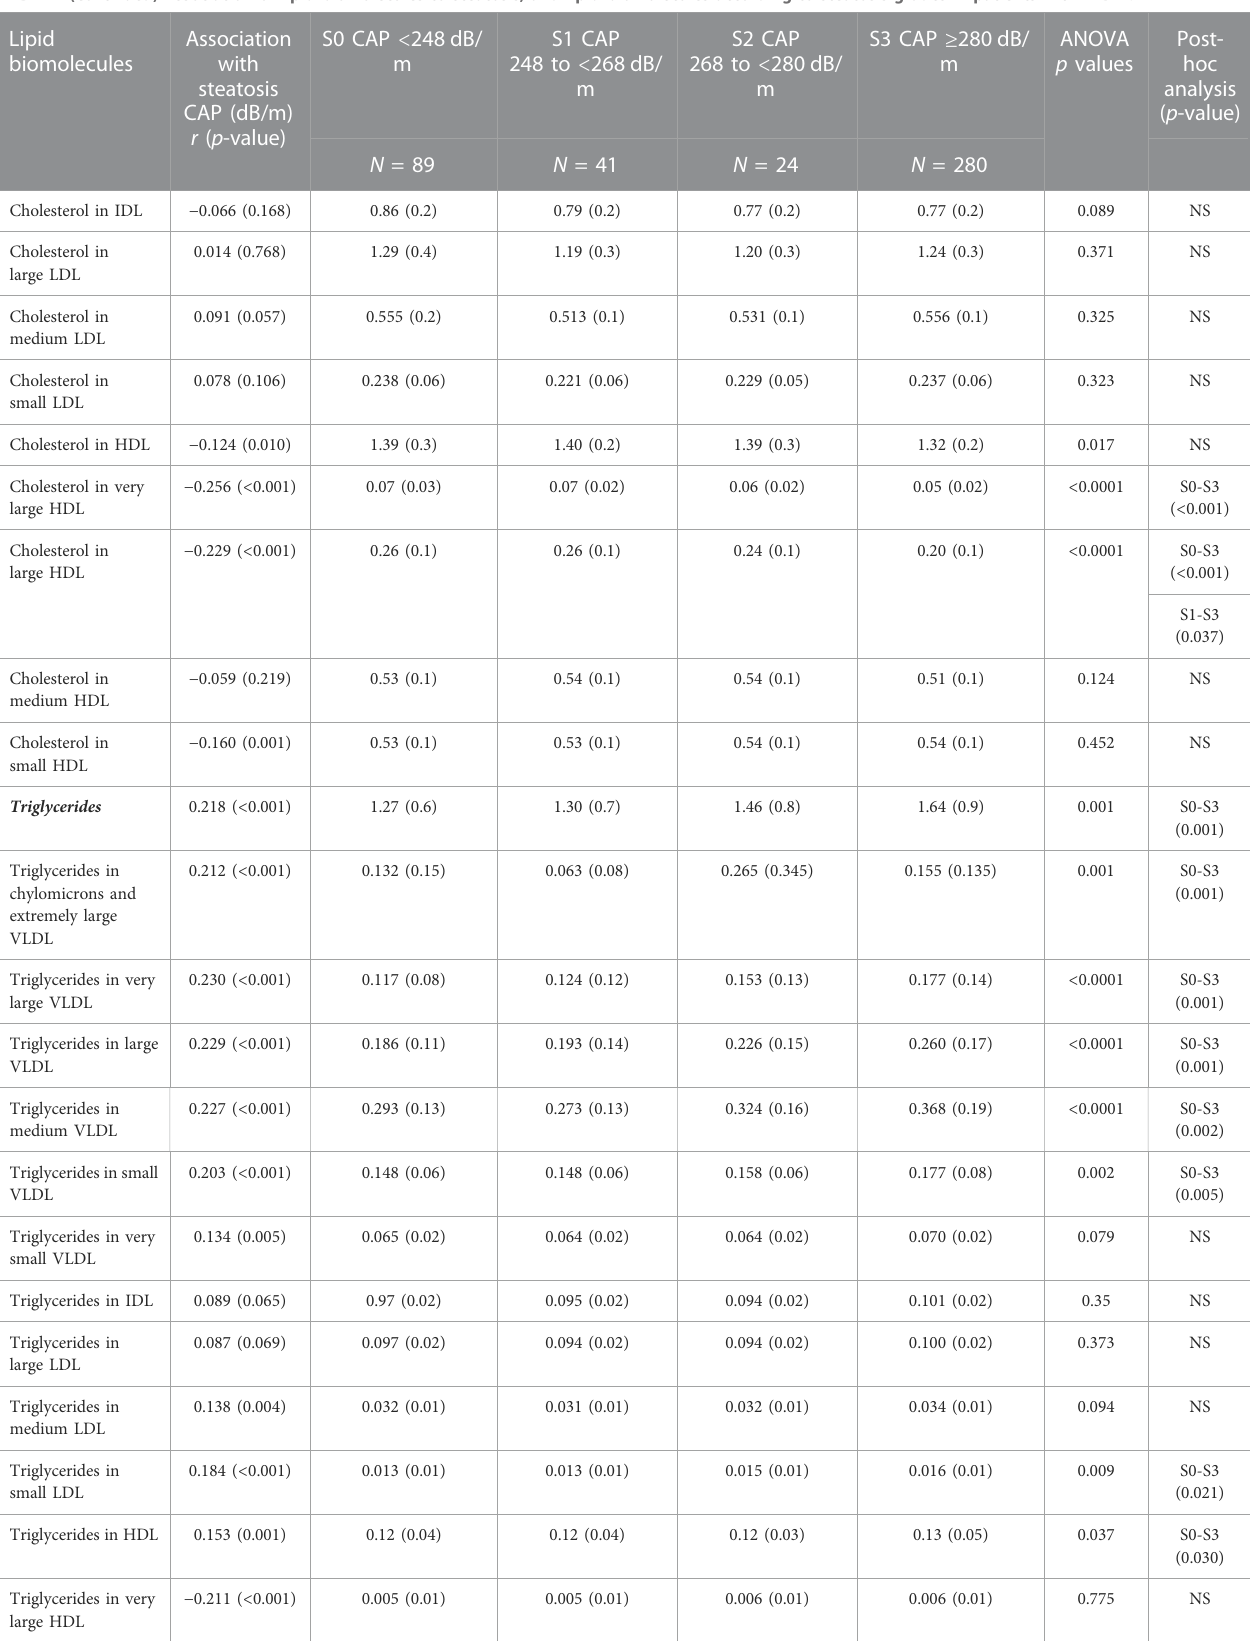
TABLE 1 ( Continued ) Association of lipid biomolecules to steatosis, and lipid biomolecules according to steatosis grades in patients with